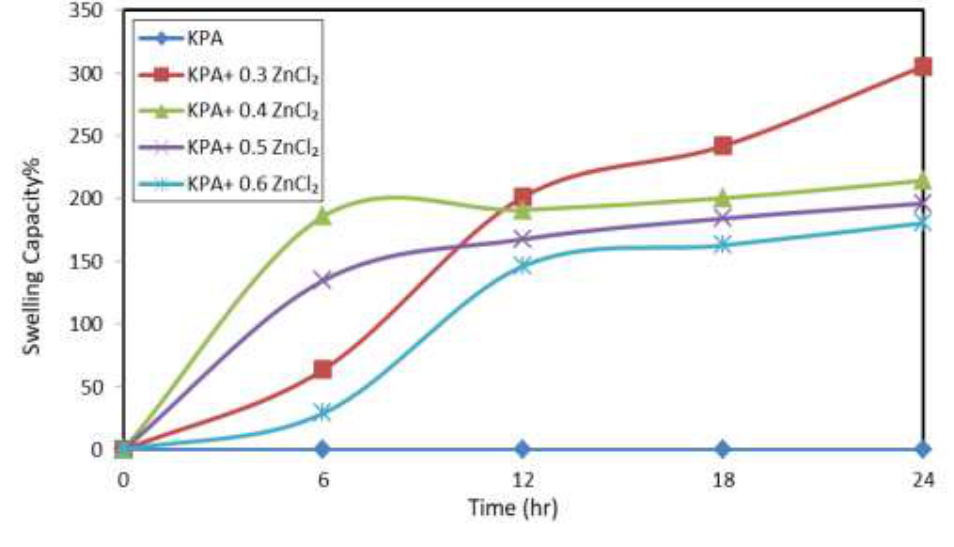
Figure 8 : Swelling Ratio (%) of KPA and (Zn-KPA)